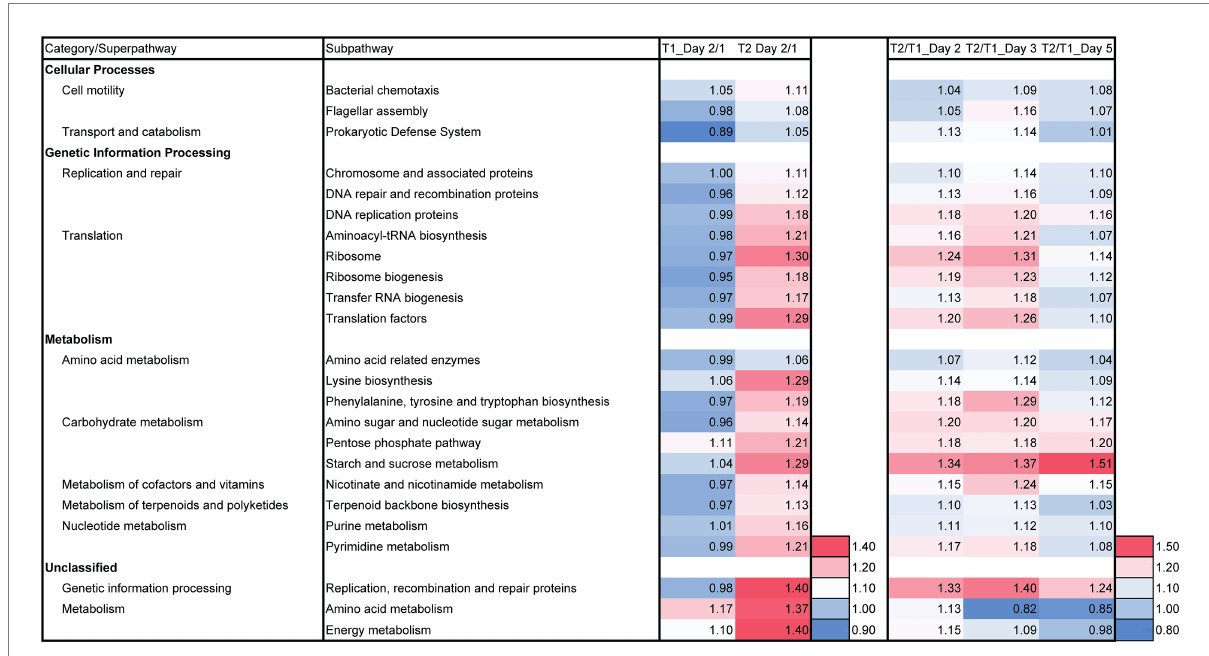
FIGURE 6 Effects of Indigofera tinctoria L. leaf powder (LP) on the ratios (day 2/day 1 and T2/T1 for days 2, 3, and 5) for each relative abundance of functional subpathway of the bacterial communities in the indigo fermentation using T- sukumo . The batches of T2 ( I. tinctoria L. leaf powder [LP] added) and T1 (control) using T- sukumo are shown. In addition, the metagenomic prediction produced using PICRUSt2 and BURRITO is shown. Subpathways containing ratios higher than 1.10 in either day 2/day 1 or T2/T1 (for days 2, 5, and 5) were